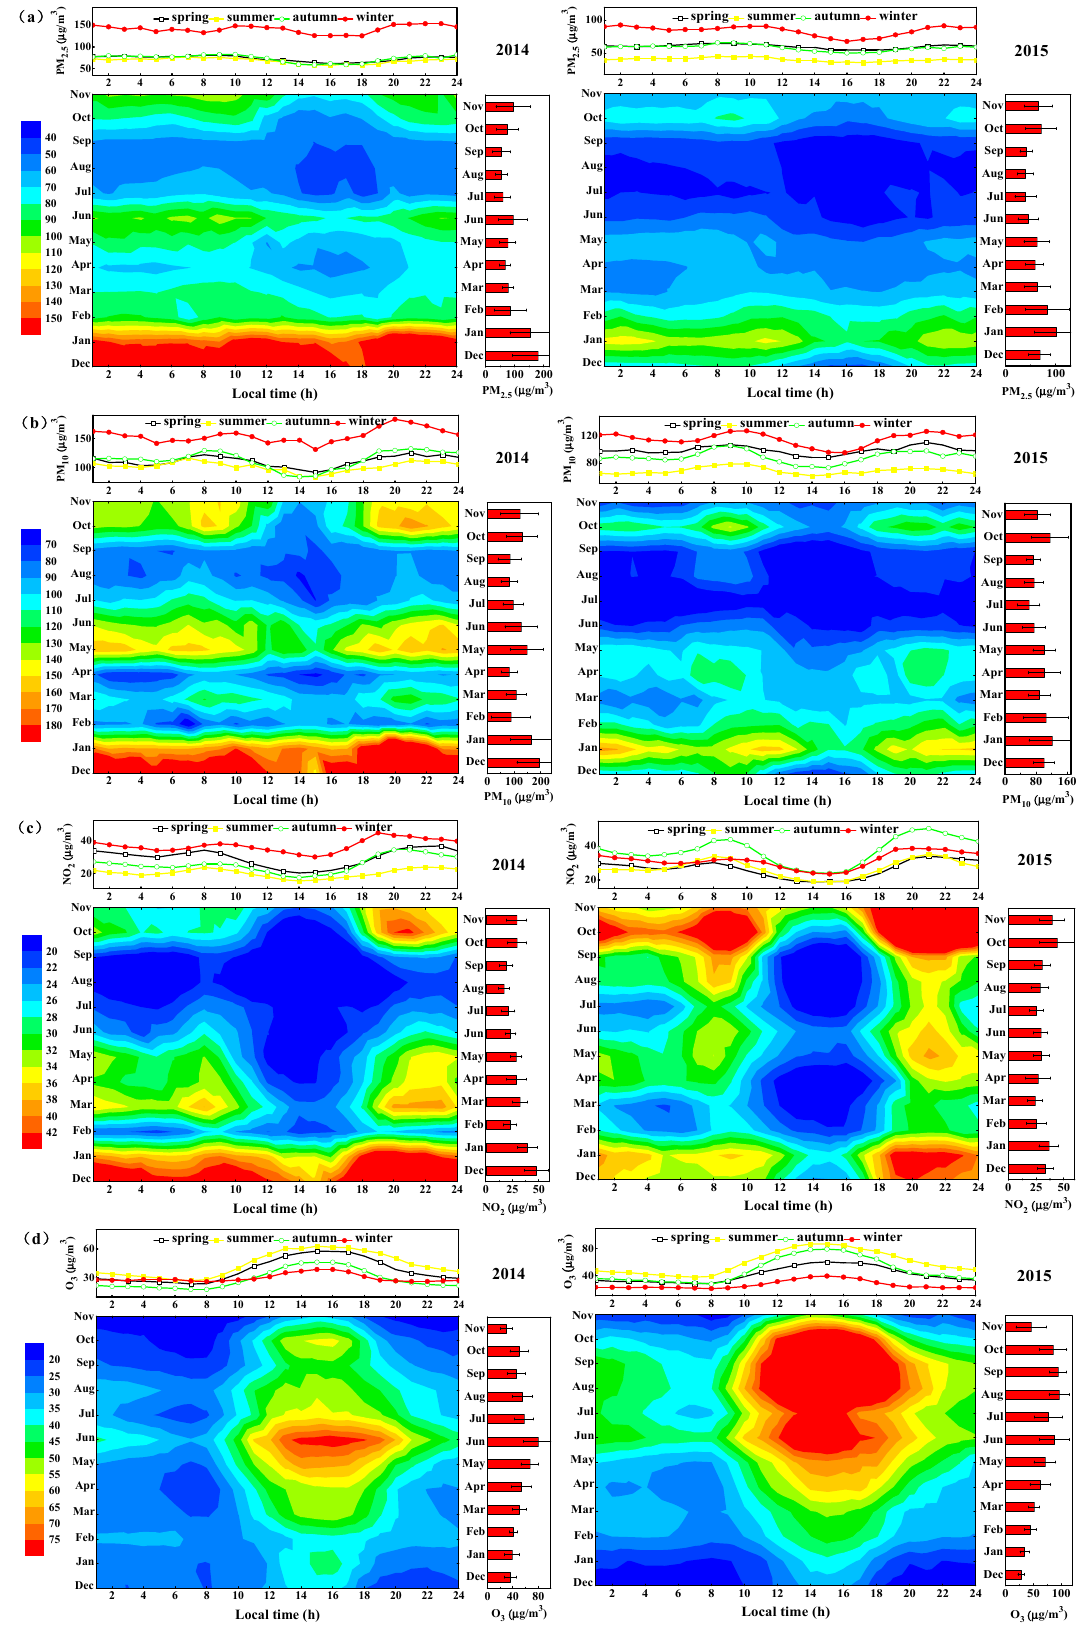
Figure 2. Diurnal variations of PM 2.5 ( a ), PM 10 ( b ), NO 2 ( c ), and O 3 ( d ).